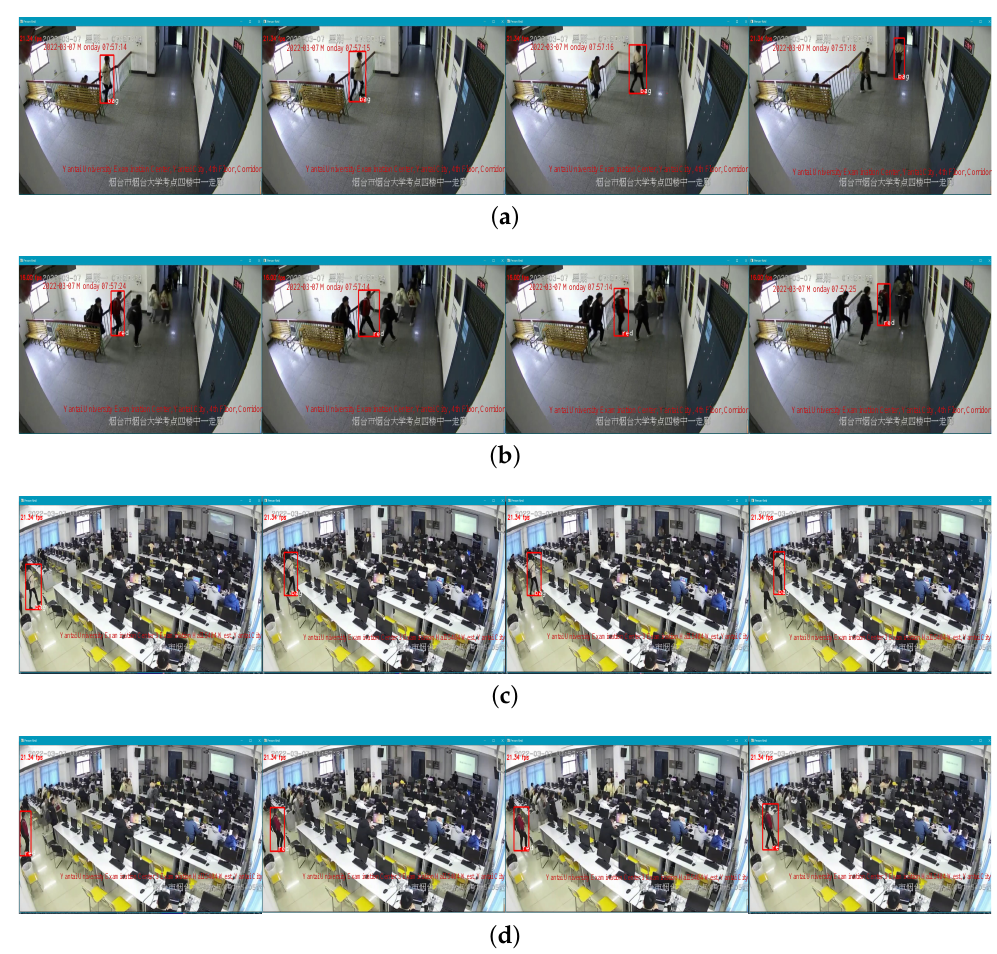
Figure 6. Real-time pedestrian re-identification in different area cross camera. ( a , b ): Display of pedestrian re-identification in area 1. ( c , d ): Display of pedestrian re-identification in area